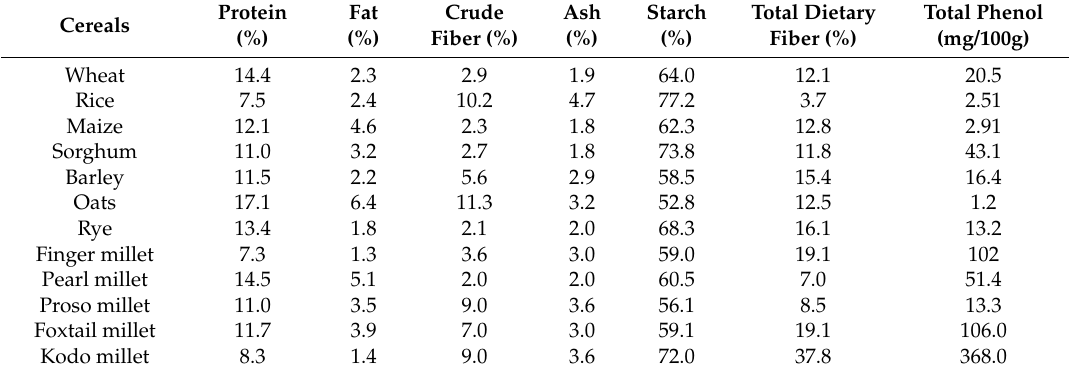
Table 2. Nutritional composition of millets and other cereals (per 100 g).